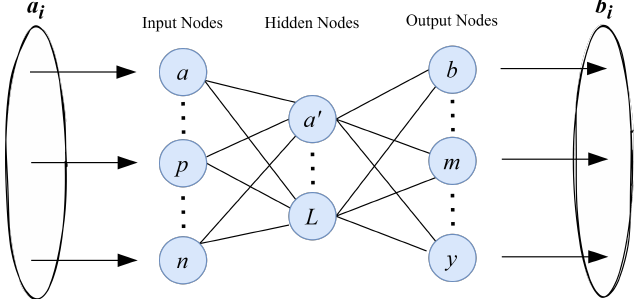
Figure 8. An abstract view of extreme learning machine